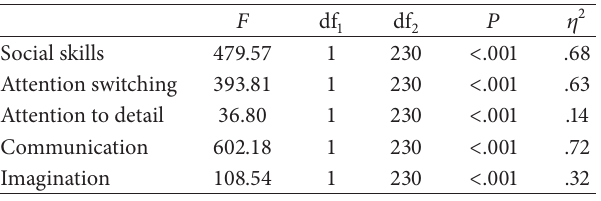
Table 5: Detailed report of diagnostic statistics for the